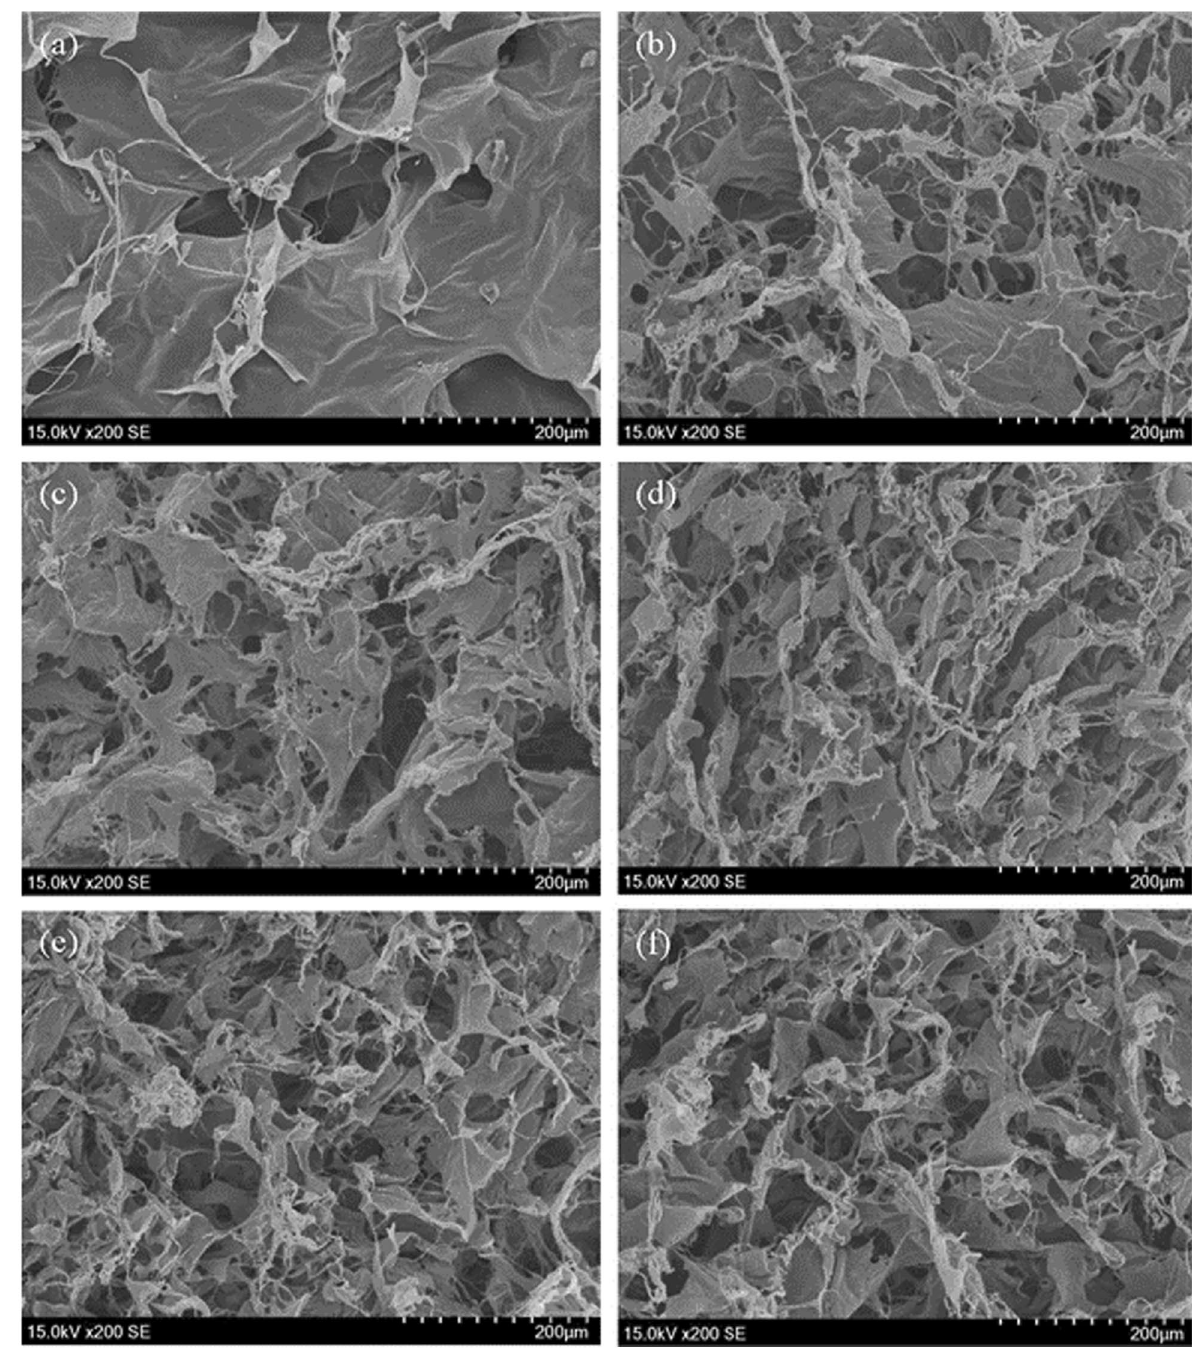
Fig. 3 SEM image of CFOB with different OBSP dosages: a CFOB-0, b CFOB-2, c CFOB-6, d CFOB-10, e CFOB-15, f